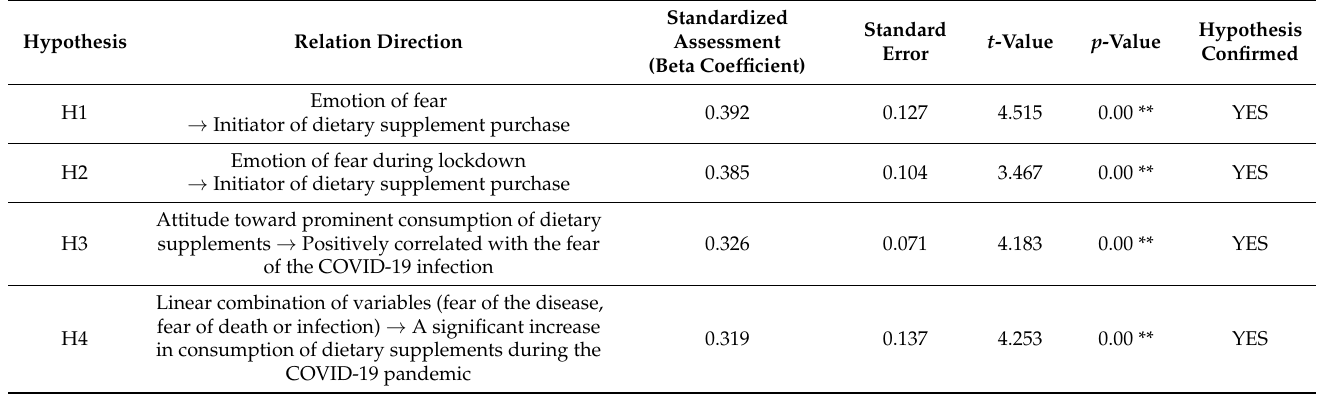
Table 6. Statistical significance of the structural coefficient between high levels of fear, risk perception and consumer behavior toward the purchase of dietary supplements during the COVID-19